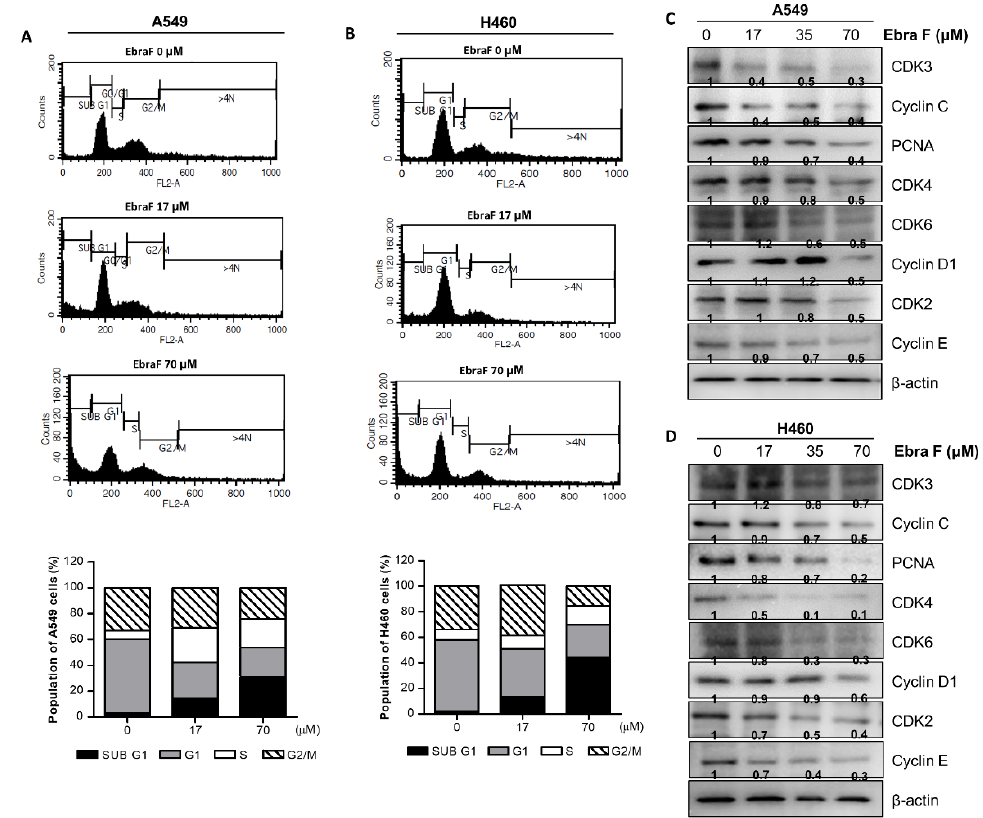
Figure 3. Effect of ebractenoid F on the cell cycle in lung cancer. Flow cytometric analysis of ebractenoid F-treated A549 and H460 cells ( A , B ). Ebractenoid F induced cell cycle arrest at the sub-G1 phase in lung cancer cells. Flow cytometry was used to determine the distribution of ebractenoid F-treated lung cancer cells in different phases of the cell cycle. Statistical analysis of the cell cycle distribution of lung cancer cells after 24 h of treatment with different concentrations of ebractenoid F. The expression levels of cell cycle-related proteins were determined by Western blot analysis using antibodies against CDK3, Cyclin C, PCNA, CDK4, Cyclin D1, CDK2, Cyclin E, and β -actin (internal control) ( C , D ). All data are expressed as the mean ±SD of three independent experiments.